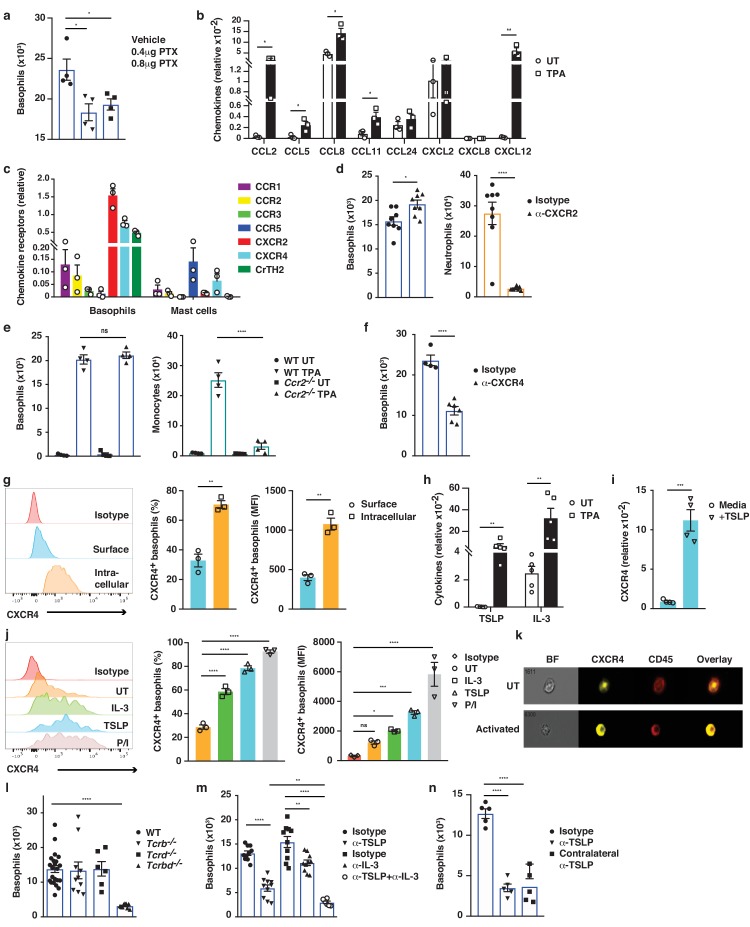
Basophil recruitment to the skin requires TSLP/IL-3-mediated upregulation of CXCR4.(a–f, h, l–n) Inflamed skin was analysed 24 hr after a single topical application of 2.5 nM TPA and compared to healthy UT skin. (a) Recruitment of basophils to inflamed skin was analysed by FACS and presented as absolute numbers of basophils in ear skin following i.v. injection of PTX or vehicle control. Basophils were gated as CD45locKit–IgE+CD41+. (b) Expression of chemokines in whole skin and (c) expression of chemokine receptors in sorted skin basophils and mast cells were analysed by qRT-PCR and presented relative to the expression of the control gene cyclophilin. (d–f) Recruitment of basophils to inflamed skin was analysed as in panel (a): (d) after i.v. injection of 50 ng anti-CXCR2 antibody, (e) in Ccr2–/– mice, or (f) after i.v. injection of 50 ng anti-CXCR4 antibody. Suitable control populations were used to show the efficacy of a treatment where appropriate. (g, i–k) Basophils were isolated from the spleen of WT mice and (g) analysed for cell surface or intracellular expression of CXCR4 by flow cytometry. (h) Expression of IL-3 and TSLP in whole inflamed and untreated (UT) skin was analysed by qRT-PCR and presented relative to the expression of the control gene cyclophilin. (i) Splenic basophils were incubated with 1 μg/ml TSLP or media alone for 24 hr, and expression levels of CXCR4 transcripts were assessed by qRT-PCR. (j, k) Basophils were activated for 24 hr with 100 ng/ml IL-3, 1 μg/ml TSLP or isotype control, with PMA/ionomycin for 4 hr, or left UT before surface expression of CXCR4 was analysed by (j) FACS or (k) total CXCR4 expression (yellow) imaged with surface staining of CD45 (red) using Imagestream. (l–n) Recruitment of basophils to inflamed skin was analysed as in panel (a): (l) in Tcrb–/–, Tcrd–/– and Tcrbd–/– mice, (m) following intradermal (i.d.) injection of 20 ng anti-TSLP or anti-IL-3 (or both) antibodies into the TPA treated ear or (n) into the contralateral ear. Representative data are shown in panels (g, j [left panels]) as histograms of CXCR4 FACS stain and in panel (k) as images from Imagestream; all other data are expressed as means ± SEM. Statistical analyses were performed by one-way ANOVA multiple comparison (a–c, e, g, j, l–n) or two-tailed Student’s t-test (d, f, h–i); *p<0.05, **p<0.01, ***p<0.001 and ****p<0.0001. UT = untreated; ns = not significant; BF = bright field.